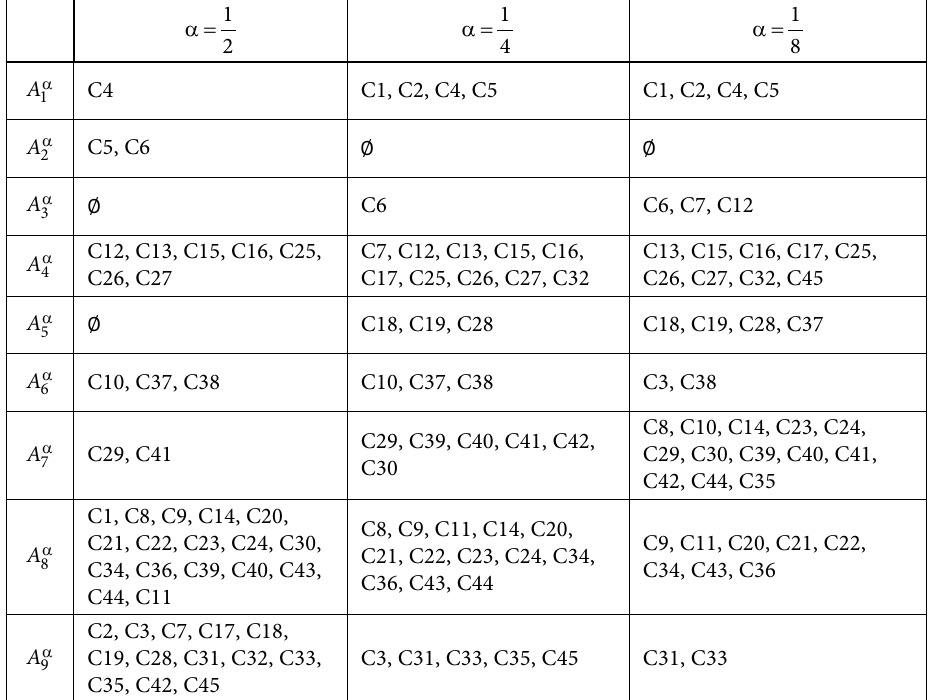
Table 5. Distribution of indicators into nine categories for various confidence values (source: Yang et al., 2018 data)